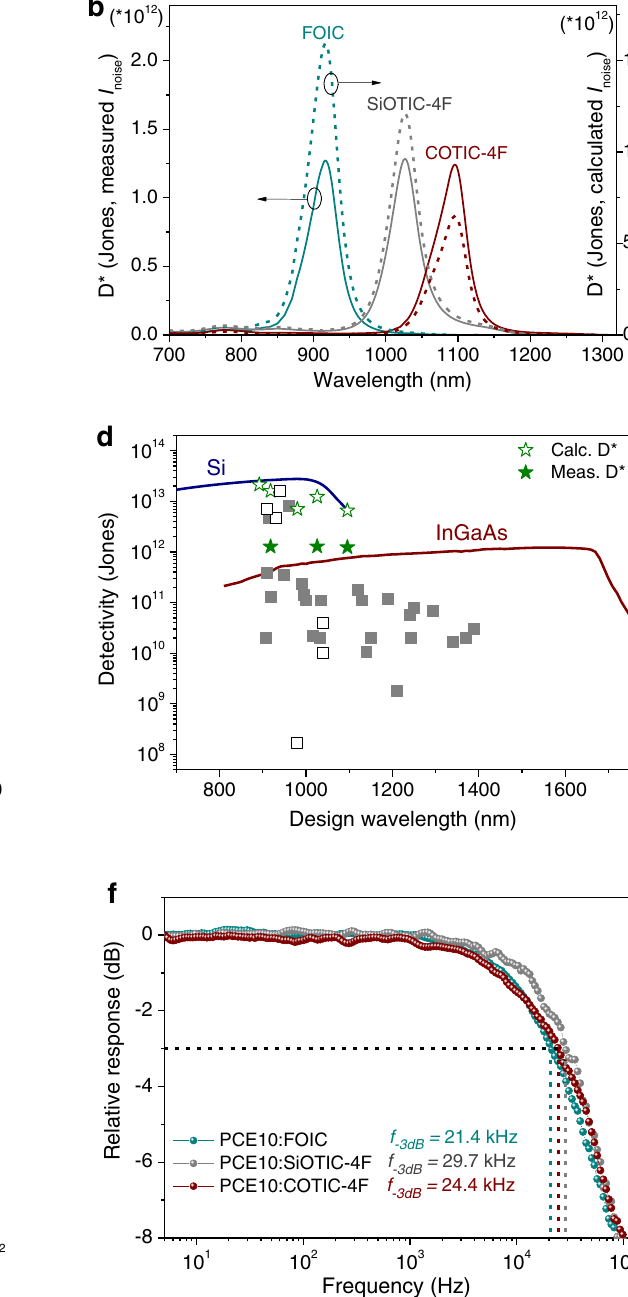
commercial inorganic broadband photodetector: Si (blue) and InGaAs (red). e Lineardynamicrange(LDR)oftheoptimizednarrowbandNIR-OPDsmeasuredat 0V.Allthethreephotodetectorsshowalinearresponseof>5ordersof magnitude versus irradiance intensity ( I ). The slope of log( I ) – log( J sc ) plots for PCE10:FOIC, PCE10:SiOTIC-4F and PCE10:COTIC-4F OPDs are 0.91, 0.95 and 0.97, respectively. f Normalized response as a function of input signal frequency. Vertical dash lines mark the cut-off frequencies obtained at −